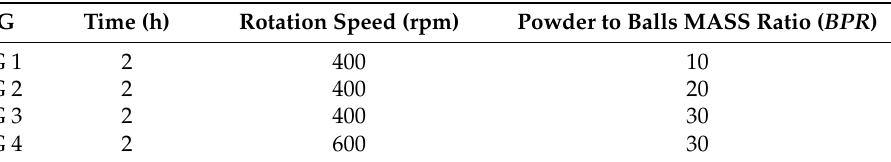
Table 2. Wet grinding settings of 45S5 Bioglass ® .